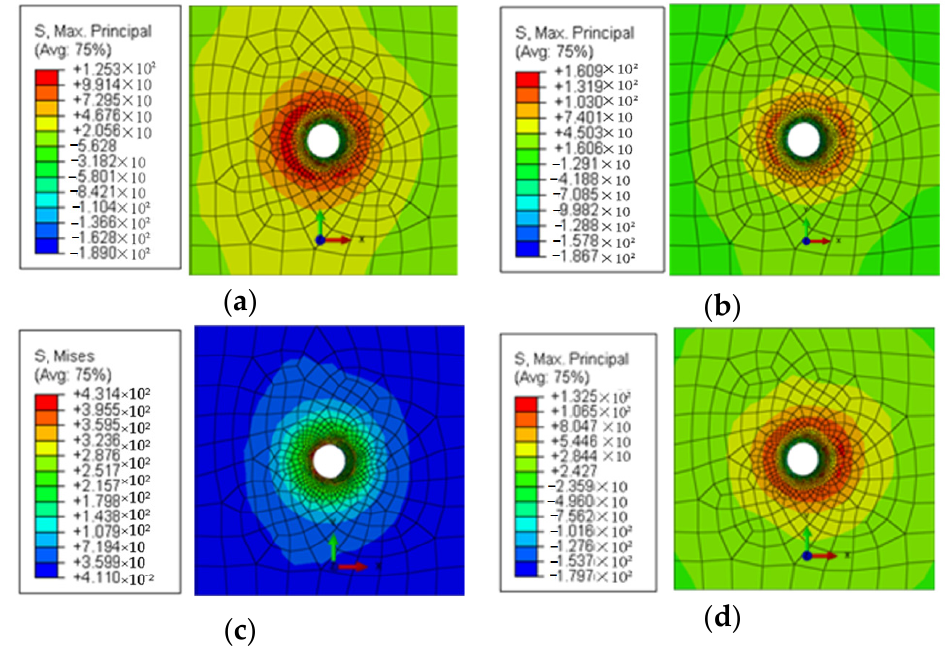
Figure 21. Distribution diagram of maximum principal stress of riveted joints in different riveting directions (unit: MPa): ( a ) distribution of maximum principal stress of riveted joints of 1 ◦ in the 0 ◦ direction (0-1); ( b ) distribution of maximum principal stress of riveted joints of 1 ◦ in the 180 ◦ direction (180-1); ( c ) distribution of maximum principal stress of 2 ◦ in the 0 ◦ direction (0-2); ( d ) distribution of maximum principal stress of 2 ◦ in the 180 ◦ direction